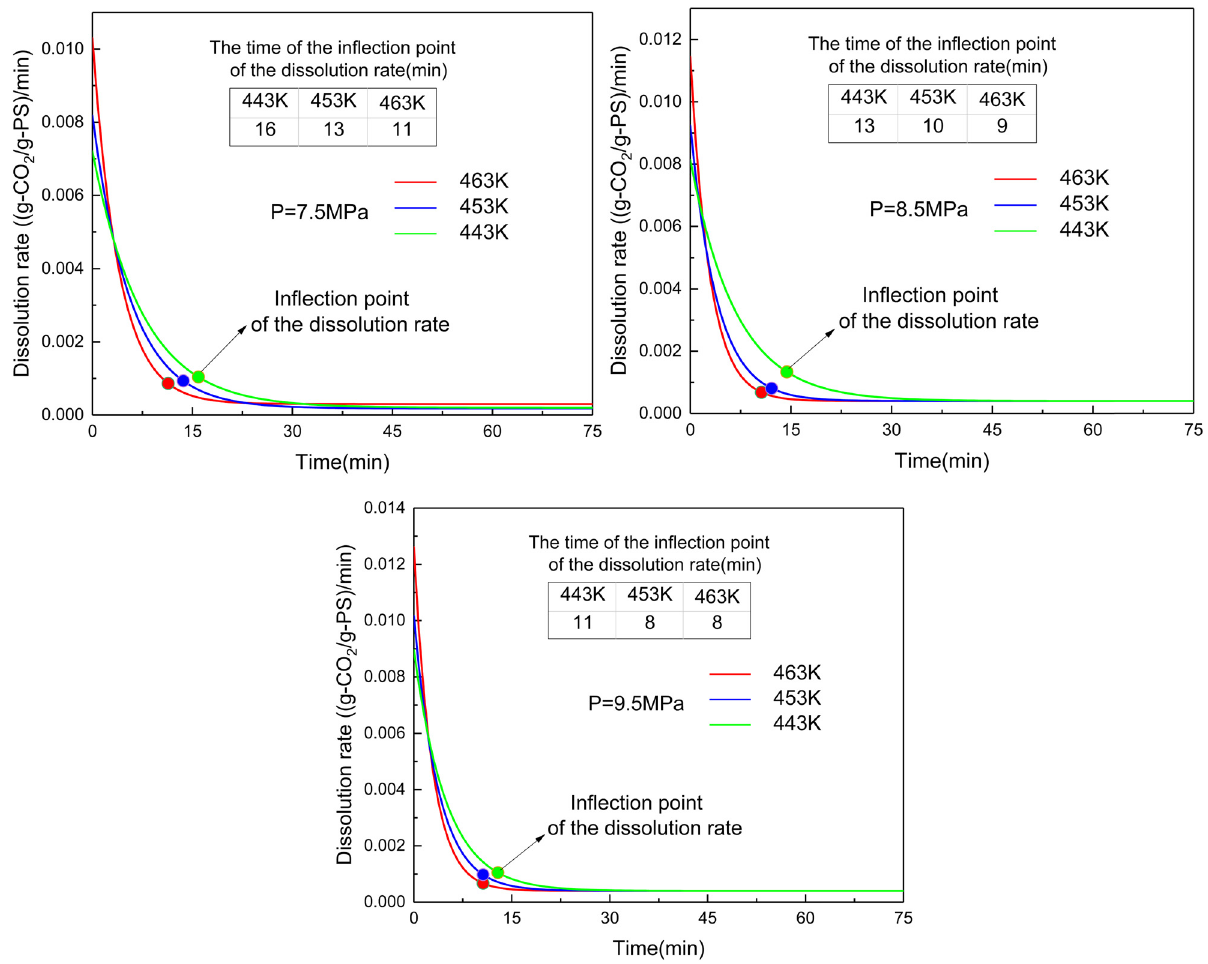
Figure 1: Dissolution rate curves at di ff erent temperatures and pressures under conical agitator and the time of the in fl ection point of the dissolution rate.